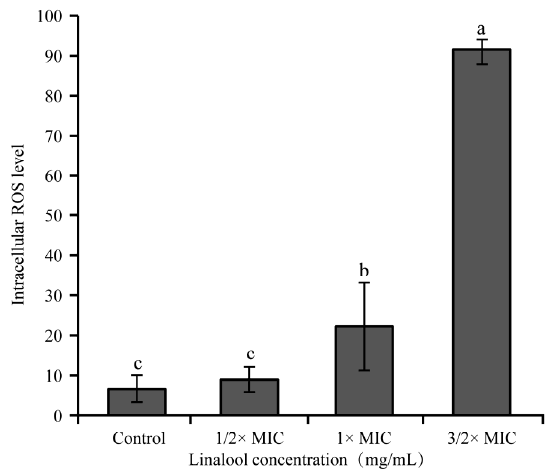
Figure 3. The effect of linalool on the ROS concentration in S. sonnei . Values represent the means of independent triplicate measurements. Bars represent the standard deviation ( n = 3). Different letters indicate a significant difference cross the figure ( p < 0.01).